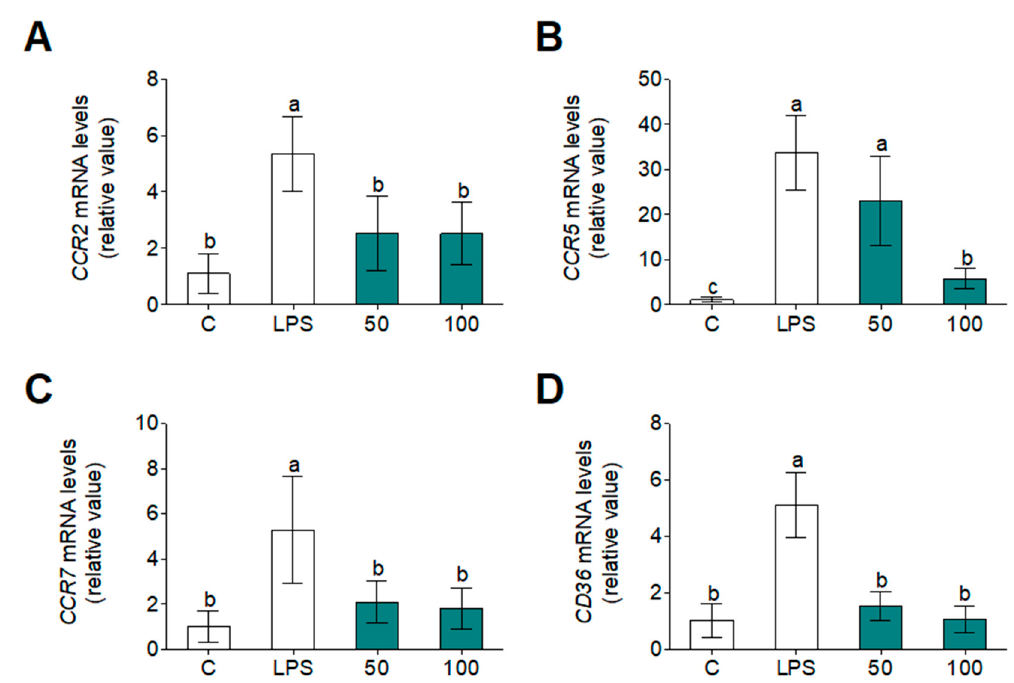
Figure 7. Gene expression of CCR2 ( A ), CCR5 ( B ), CCR7 ( C ), and CD36 ( D ) in primary human monocytes after 24 h incubation with or without LPS (100 ng/mL) and WGPH45A at 50 and 100 μ g/mL. Data are expressed as means ± SD ( n = 3) and those marked with different letters are significantly different ( p < 0.05).